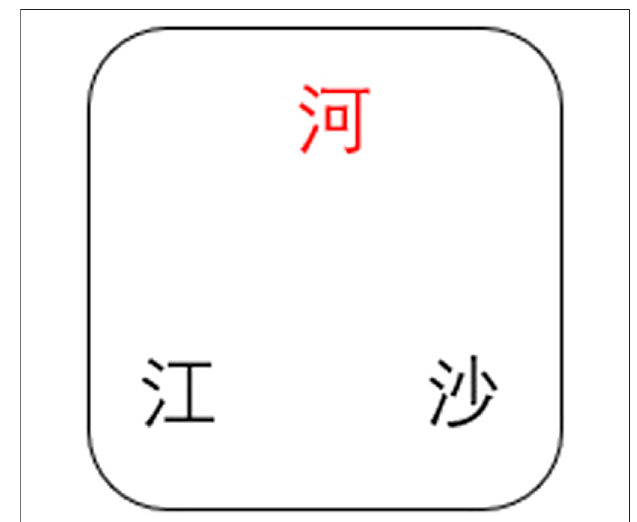
FIGURE 1 | An example of material for Experiment